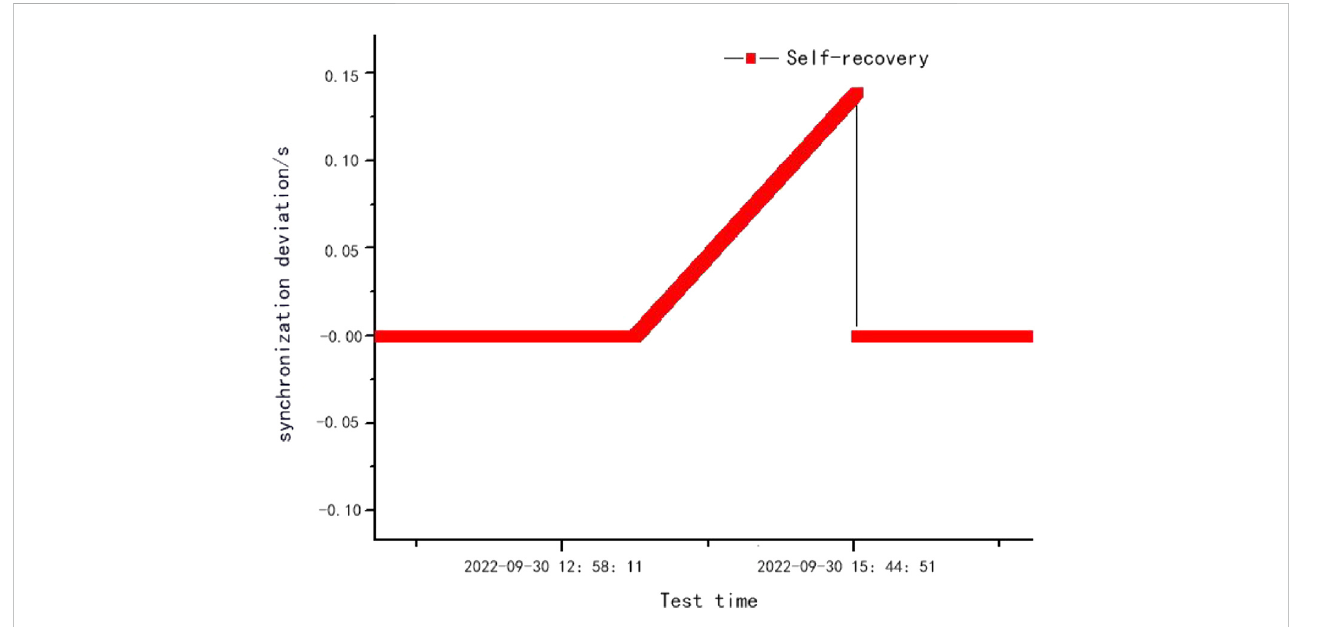
FIGURE 8 Self-recovery experiment when power supply is